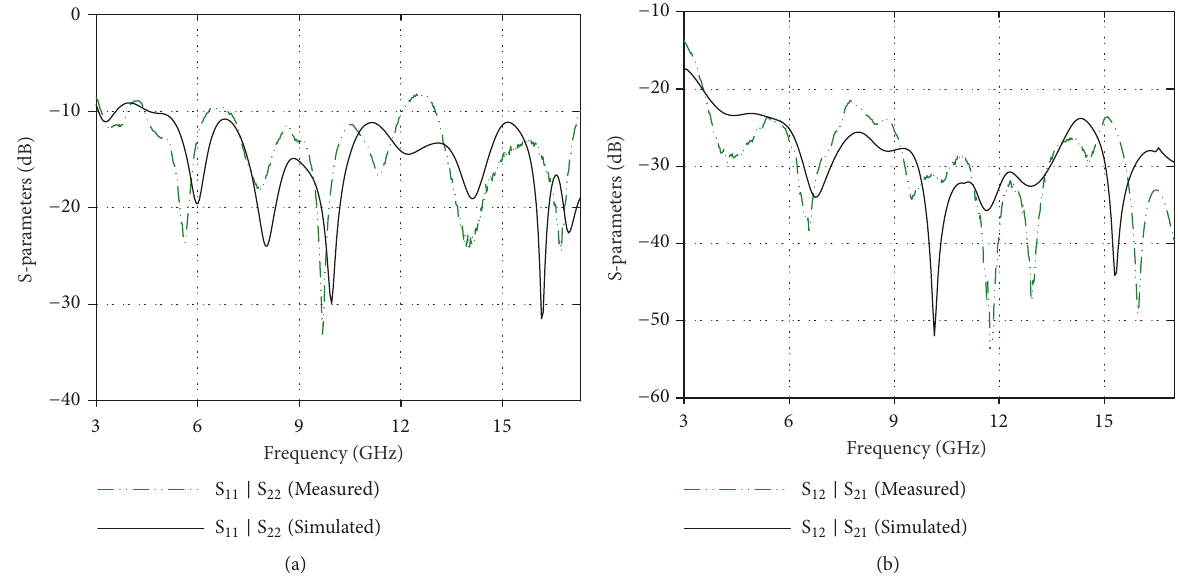
Figure 5: Simulated and measured S-parameters of the proposed UWB-MIMO antenna: (a) S 11 (dB), (b) S 21 (dB).